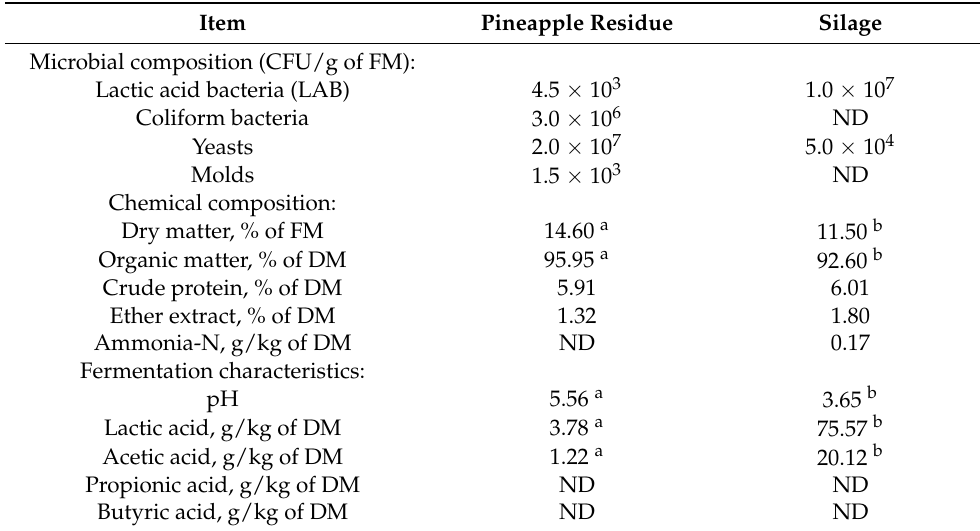
Table 1. The microbial composition, chemical component and quality of pineapple residue raw material and silage. Item Pineapple Residue Silage Microbial composition (CFU/g of FM): Lactic acid bacteria (LAB) 4.5 × 10 3 1.0 × 10 7 Coliform bacteria 3.0 × 10 6 ND Yeasts Molds 1.5 × 10